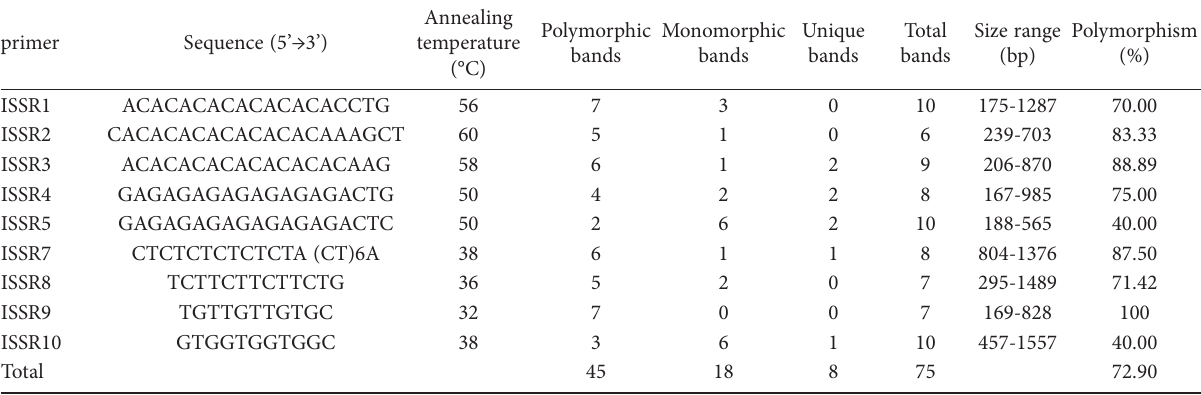
Table 5. Sequences and annealing temperature of nine ISSR primers were used to access genetic disorder of the root tip of Vicia faba (Misr 3 cultivar) as influenced by Al concentration and exposure time. Size of amplified fragments (bp), total number of amplified fragments, number of polymorphic bands, unique bands and specific bands identified per primer were